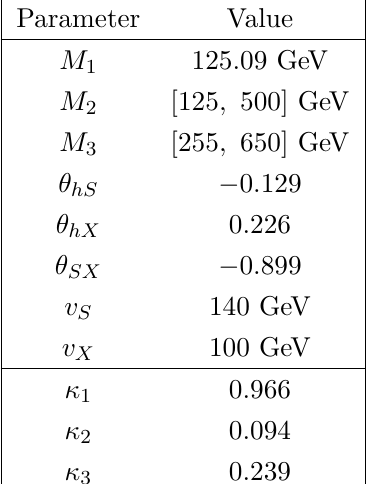
Table 1 . The numerical values for the independent parameter values of eq. (2.12) that characterise BP3 . The Higgs doublet vev, v , is fixed to 246 GeV. The κ i values correspond to the rescaling parameters of the SM-like couplings for the respective scalars and are derived